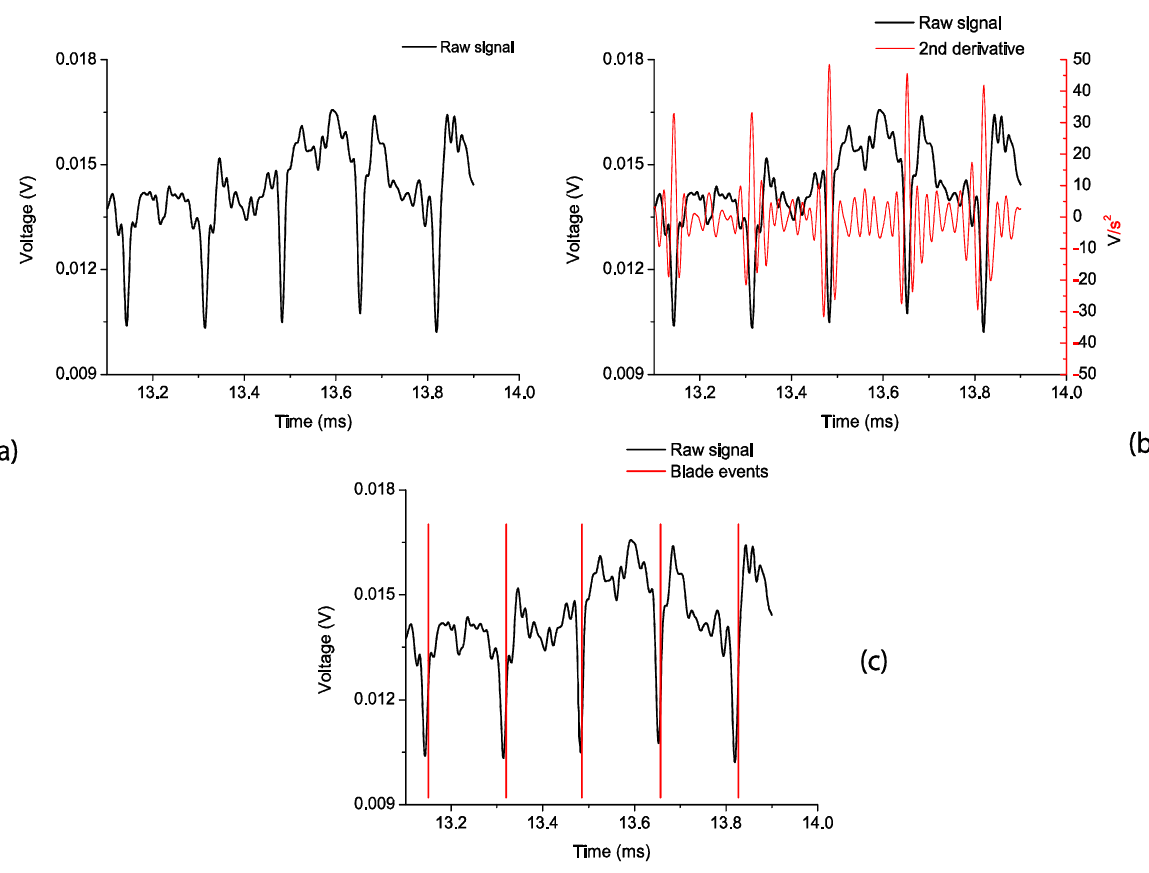
Figure 7. ( a ) Raw signal of photodetector 2. ( b ) Second derivative of the raw signal. ( c ) Detected blade